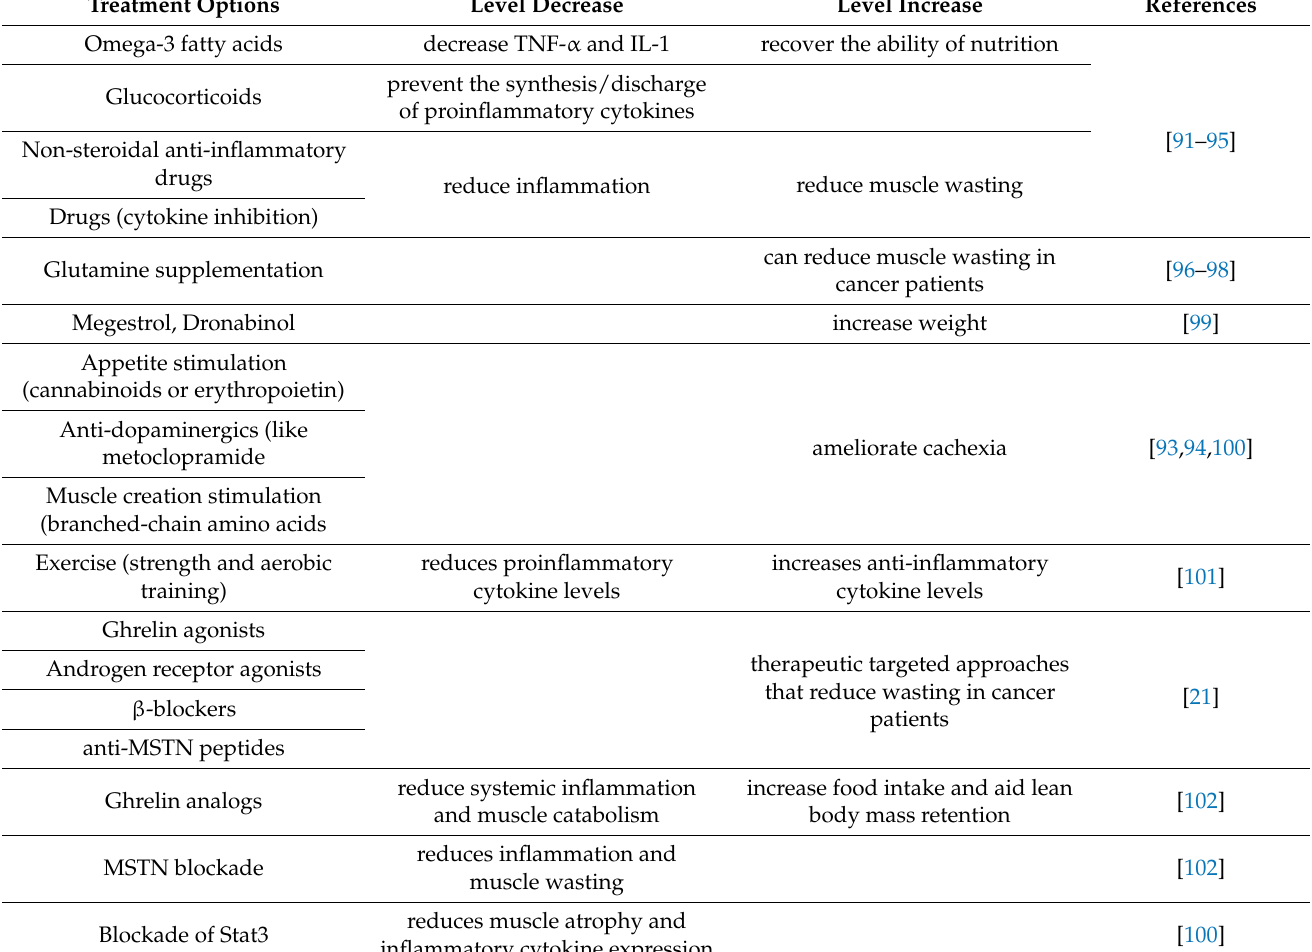
Table 1. List of therapeutic agents and factors available for the management of cancer